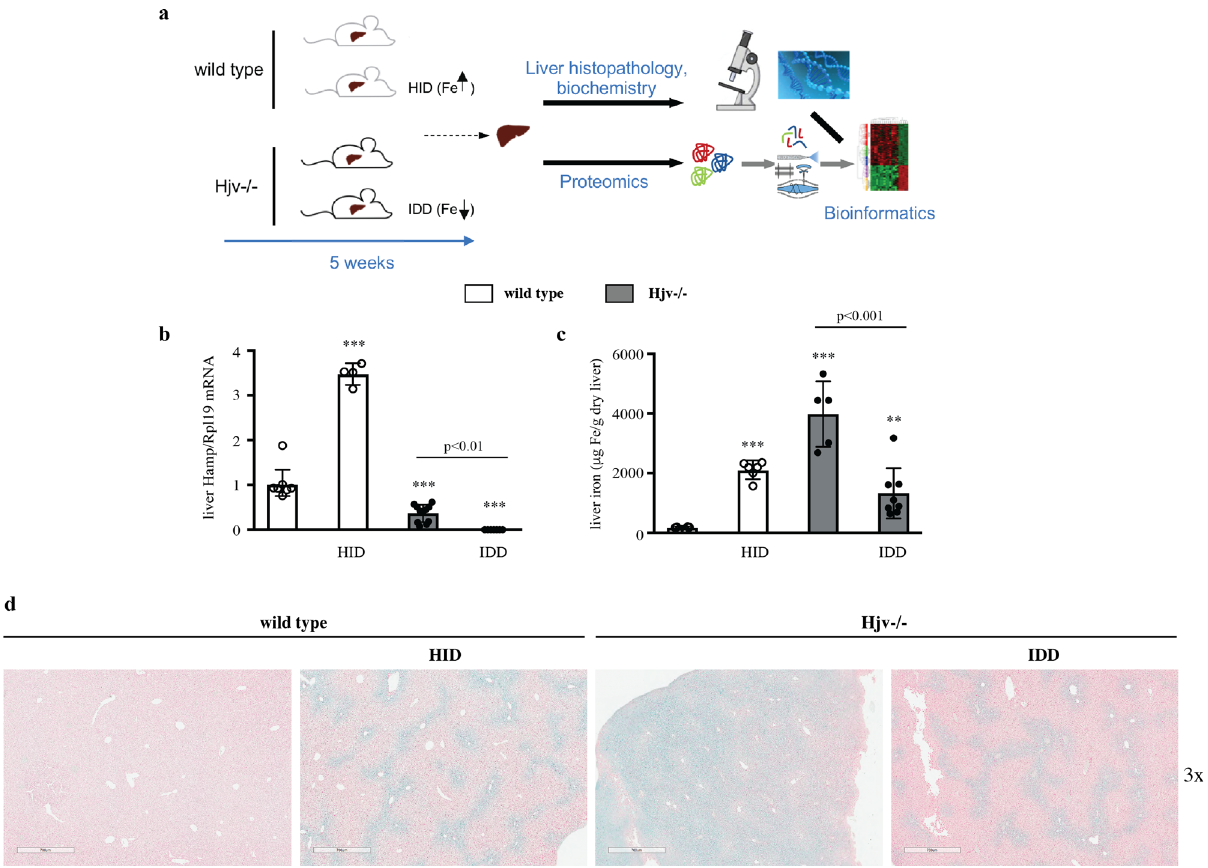
Fig. 5 Dietary iron manipulations in wild type and Hjv − / − mice. 4-week-old male wild type and Hjv − / − mice ( n = 8 – 10 per group) were fed a standard diet, a high iron diet (HID) or an iron-de fi cient diet (IDD). All animals were sacri fi ced after 5 weeks; livers were dissected and processed for biochemical, histological and proteomics analysis. a Schematic representation of the experimental design. b qPCR analysis of Hamp mRNA. c Quanti fi cation of liver iron. d Perls Prussian blue staining in liver sections (magni fi cation: 3x). Data in ( b – c ) are presented as the mean ± SEM. Statistical analysis was performed by two-way ANOVA. Statistically signi fi cant differences across genotypes are indicated by **( p < 0.01) or ***( p <